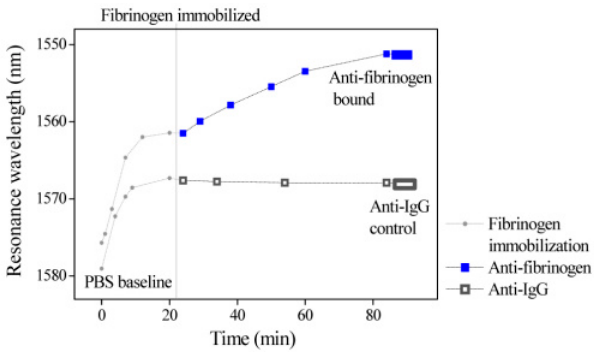
Figure 28. Comparison of spectral response for the anti-fibrinogen detection and anti-IgG [135].